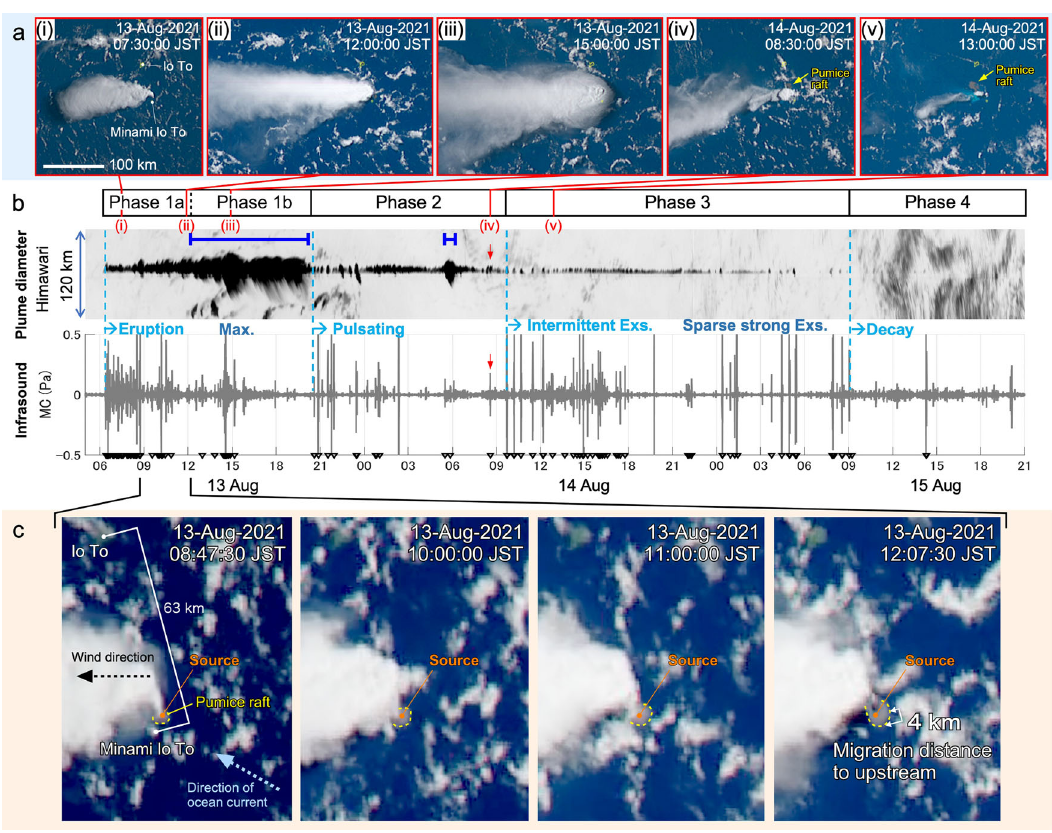
Fig. 2 Timeseries data from remote observations of the 2021 FOB eruption. a Developing eruption plume captured by Himawari-8 (JMA, delivered by NICT) at fi ve times. b Change in the diameter (north-south direction) of the eruption plume captured by Himawari-8 (upper) and infrasound data at 5 – 15 Hz recorded at Chichijima (bottom). Time is JST. Inverted triangles indicate infrasound signals con fi rmed to be from the FOB direction. Blue bars indicate times of development of the sustained eruption columns. Red arrows indicate signals of a typical Surtseyan eruption occurred at 8:30 on 14 August 2021 [(iv) in fi gure ( a )]. The eruption is divided into four major phases: Phase 1, the initial intense phase with sustained plumes; Phase 2, the pulsating phase; Phase 3, intermittent and sparse strong explosions; and Phase 4, decay, which is characterised by weak infrasound and little or no plume development from the source, with only ambient clouds being captured. c Magni fi cation of the source area at the beginning of Phase 1. The Himawari-8 images obtained by JMA and processed by the Digital Typhoon Project of